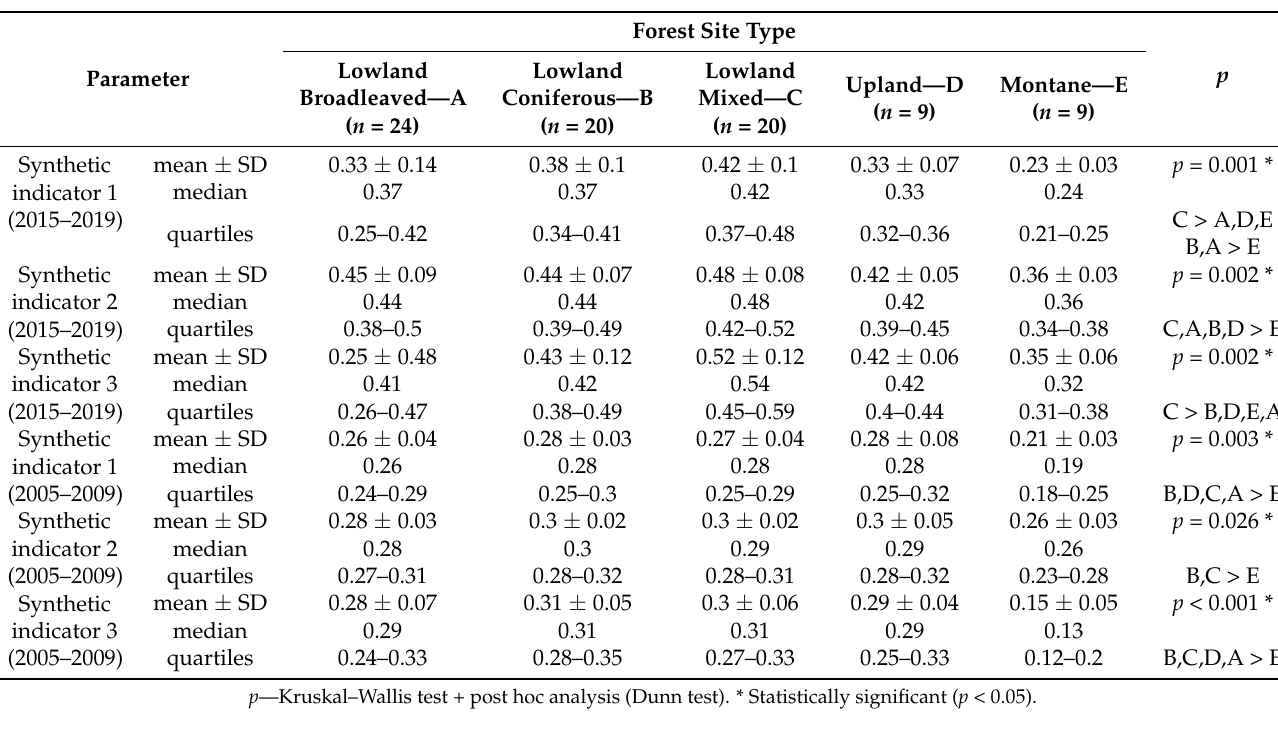
Table 3. Relationships between the synthetic indicators and forest district categories distinguished on the basis of forest site types.